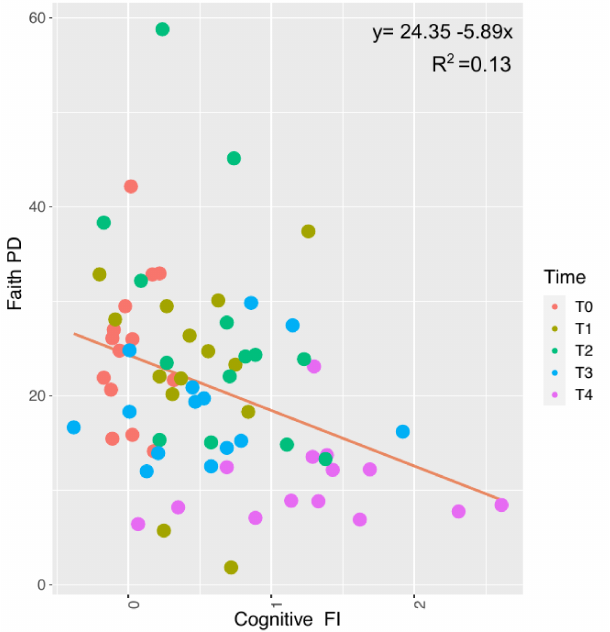
Figure 8. Figure plotting the correlation between Faith’s phylogenetic distance (PD) index and Cognitive FI. Reported is the linear regression equation used to fit experimental data. Colors in the graphs are reported according to the different experimental times as shown in the figure